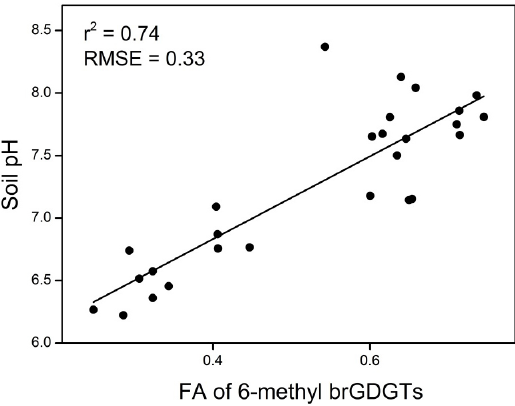
Figure 9. Scatterplots of soil pH versus CBT 5ME and soil pH versus IBT based on 27 soil samples in the